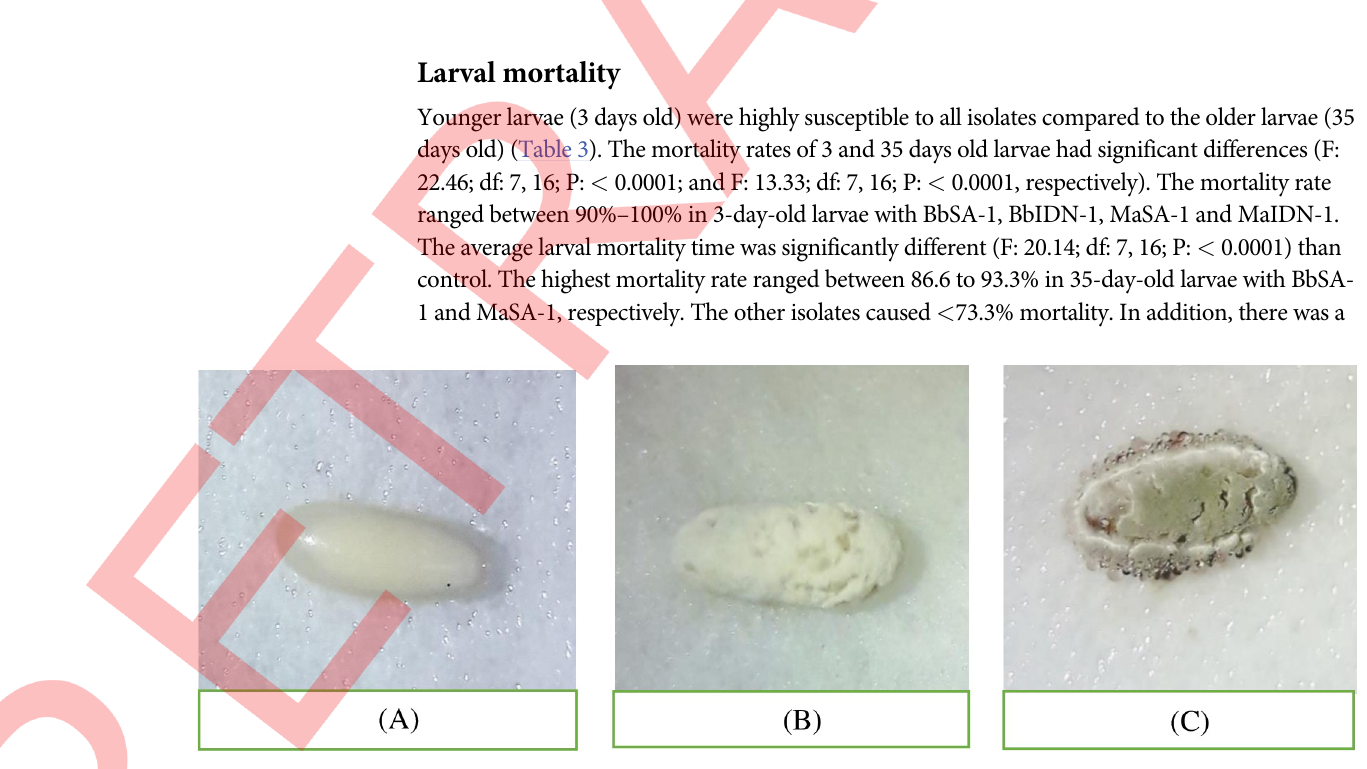
Fig 1. Comparison of healthy and fungi-treated red palm weevil eggs. Healthy egg, exposed to distilled water (control) (A) and infected egg, exposed to fungi Beauveria bassiana (B) and Metarhizium anisopliae (C) (treated) (1 × 10 9 conidia/ml) under laboratory condition.